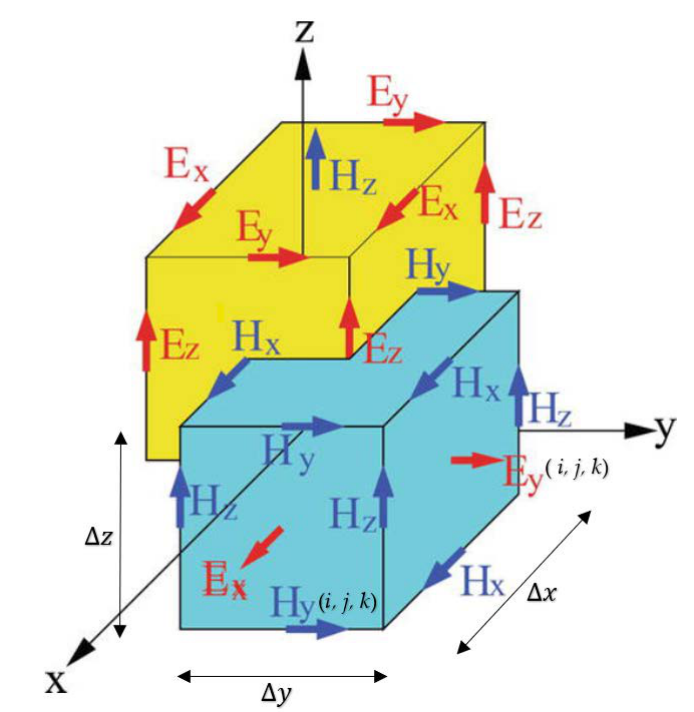
Figure 1. The “Yee lattice” [29] is used to discretize equations of Maxwell in space. The orientation of components of the electric (E) and magnetic field (H) in the x , y , and z directions can be seen here. Here, i , j , and k denote the values of the co-ordinates in the x , y , and z directions,